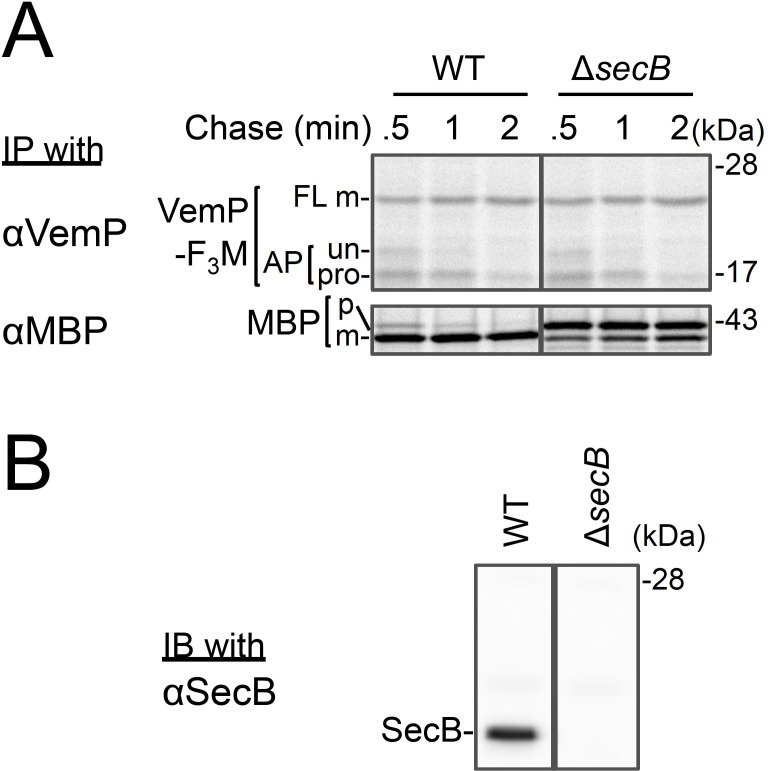
Effects of a secB-deletion on the stability of the arrested VemP.(A) WT cells or ΔsecB cells carrying a vemP-3xflag-myc plasmid were grown at 30°C until early log phase, induced, pulse-labeled, and chased as in Figure 4. At the indicated chase time points, total cellular proteins were acid-precipitated and subjected to IP with the indicated antibodies and analyzed as in Figure 1. The result shown is a representative of two biological replicates. (B) Separately, the cells were acid-precipitated at the time just before the pulse-labeling. After SDS-solubilization, proteins were subjected to immunoblotting with an anti-SecB antibody.